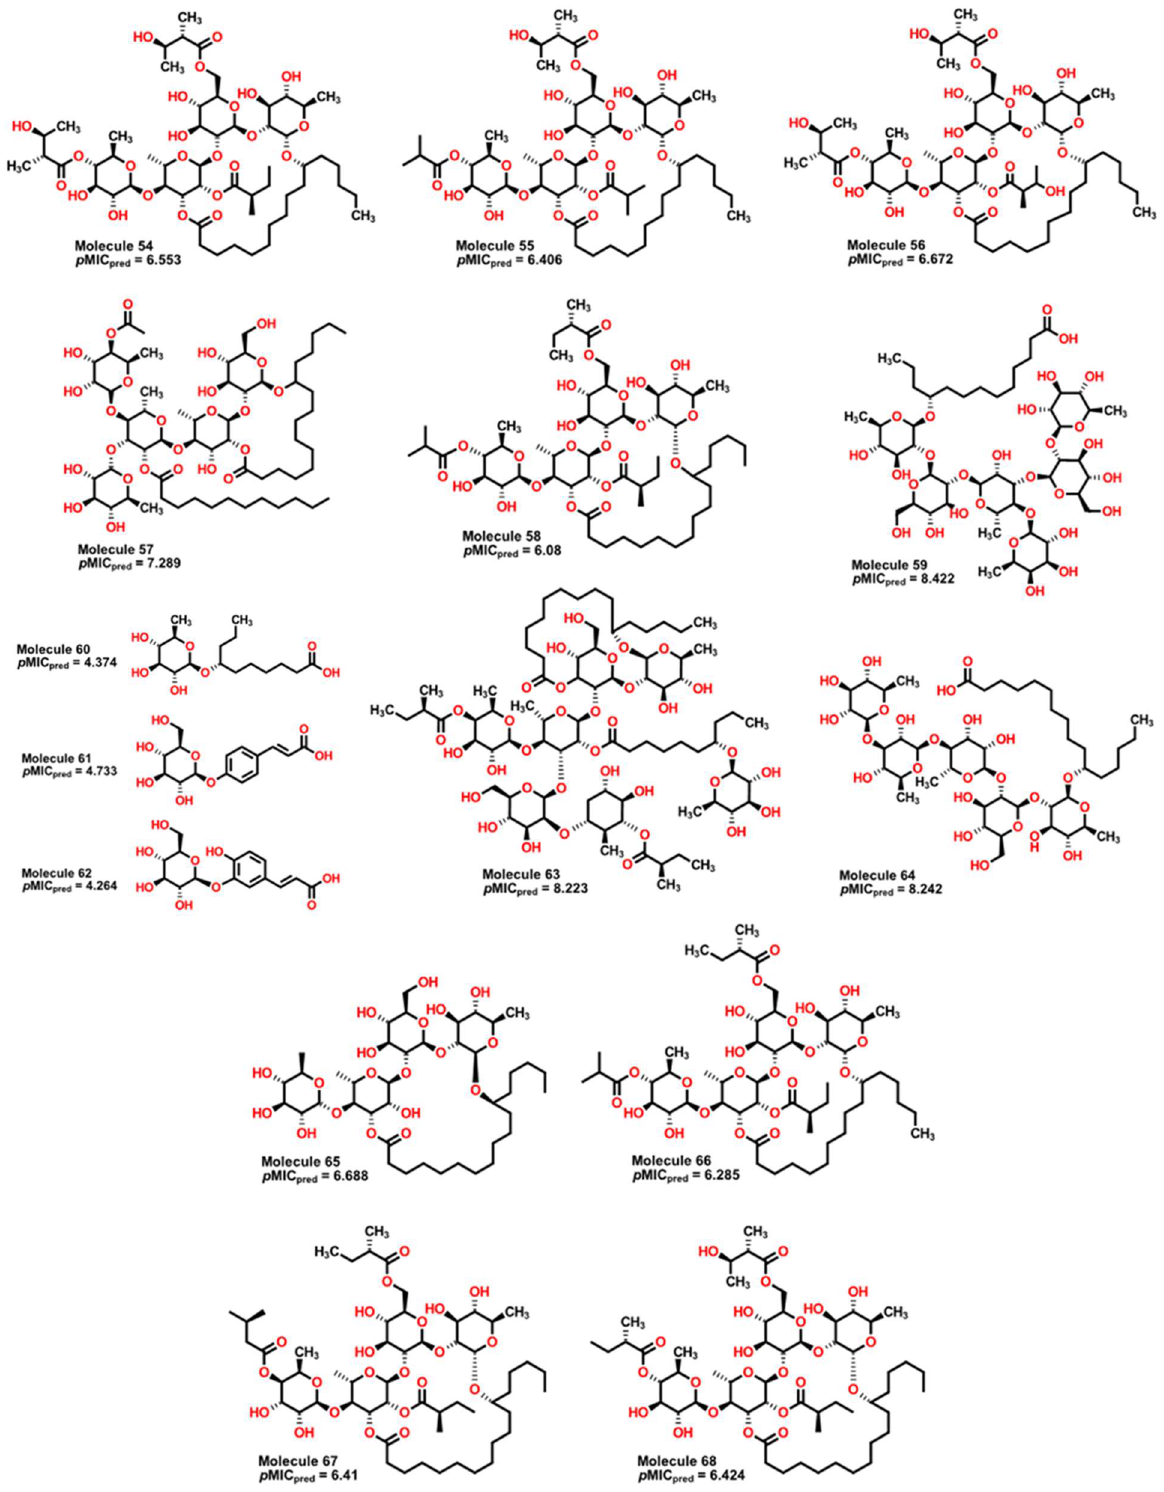
Figure 15. Molecular structure of natural products isolated from different species of Ipomoea . Molecules 59 , 63 , and 64 display high values of predicted p MIC, while compounds 60 to 62 show the lowest values.